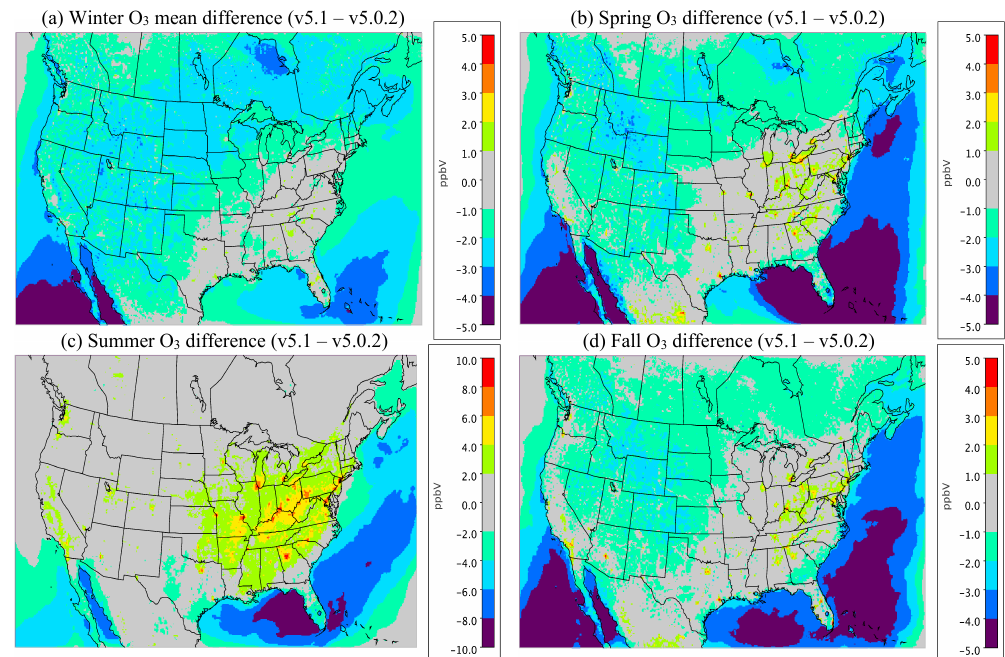
Figure 11: Difference in the monthly average hourly O 3 (ppbv) for winter (DJF; top left), spring (MAM; top right), summer (JJA; bottom left) and fall (SON; bottom right) between CMAQ v5.0.2_Base and v5.1_Base (CMAQv5.1_Base – CMAQv5.0.2_Base). Note that the scales for each plot can vary.